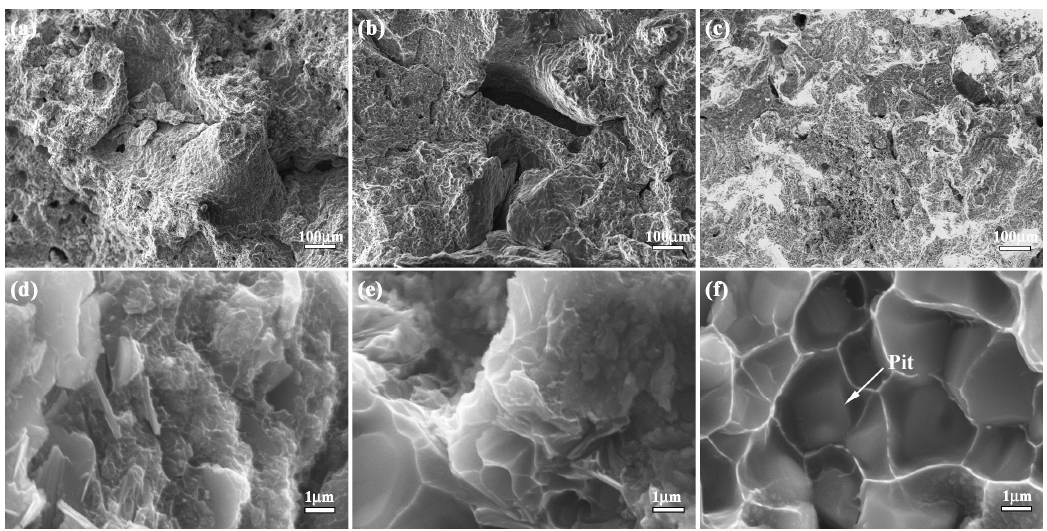
Figure 8. Fracture appearance of bionic layered composite ( a ) outer layer ( b ) middle layer ( c ) inner layer ( d ) magnified microstructure of ( a ); ( e ) magnified microstructure of ( b ); and ( f ) magnified microstructure of ( c ).